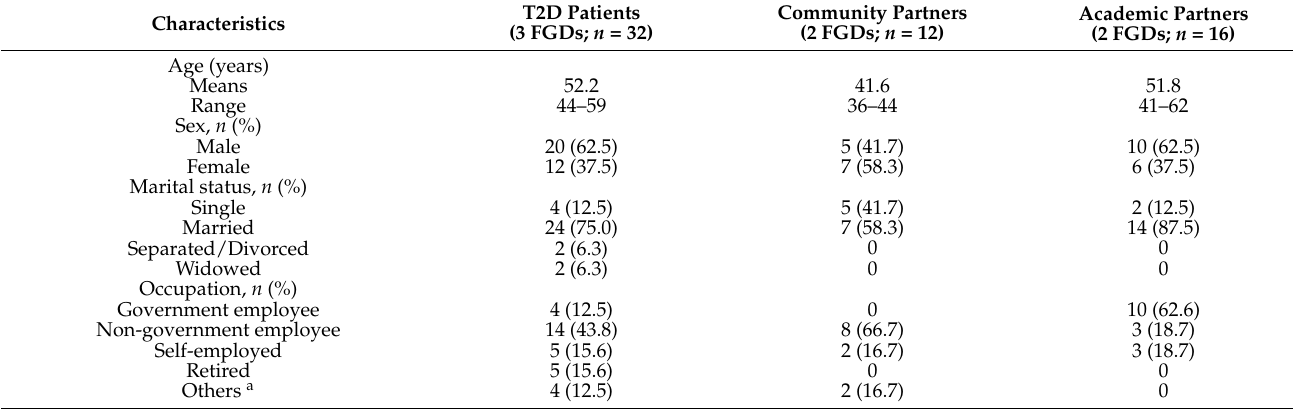
Table 1. Summary of respondent characteristics engaged in the focus groups, by respondent group.